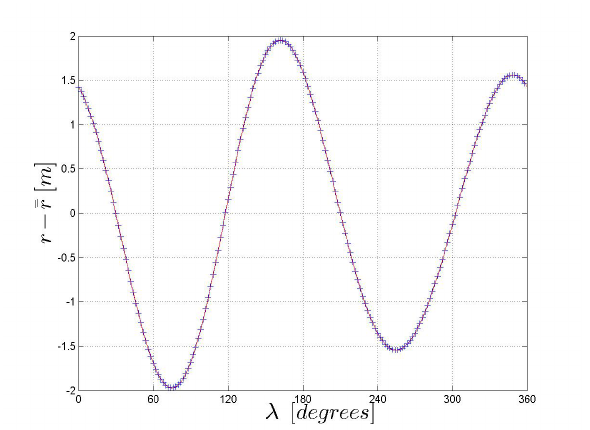
Figure 2: The variation of the radius ( r ) of zero gravity along the equator. The vertical axis shows dr = r − ¯¯ r in metre, where ¯¯ r = 42164.17 km is the average radius along the equator. The horizontal axis shows the